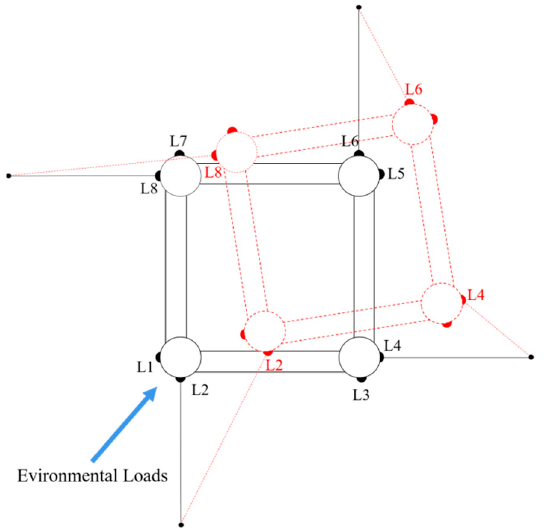
Figure 26. Diagram of the movement trend of inclined tendons. (L1, L3, L5, L7 are typical tendons, and L2, L4, L6, L8 are inclined tendons with more complicated tension phenomena.)